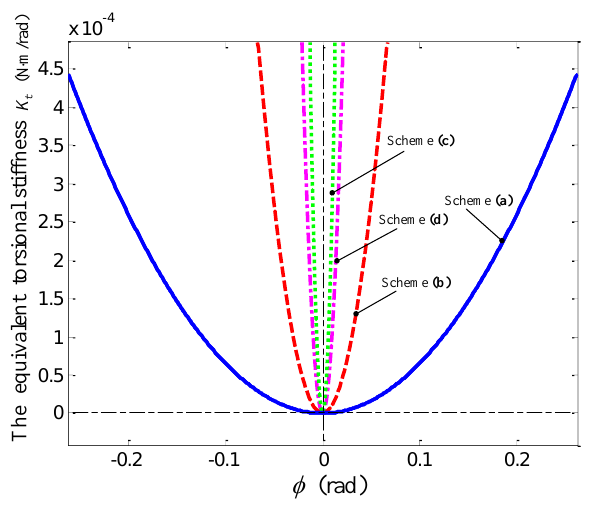
Figure 6. Comparison curves of equivalent torsional stiffness.